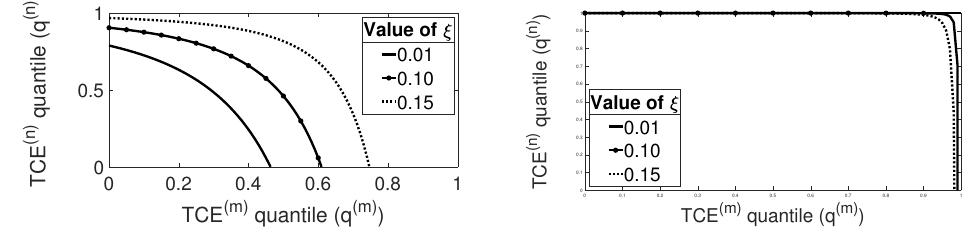
Figure 7. Extended TCE quantile at order n = 2 as a function of extended TCE quantile at order m = 5. ( Left panel ): θ = 1. ( Right panel ): θ =